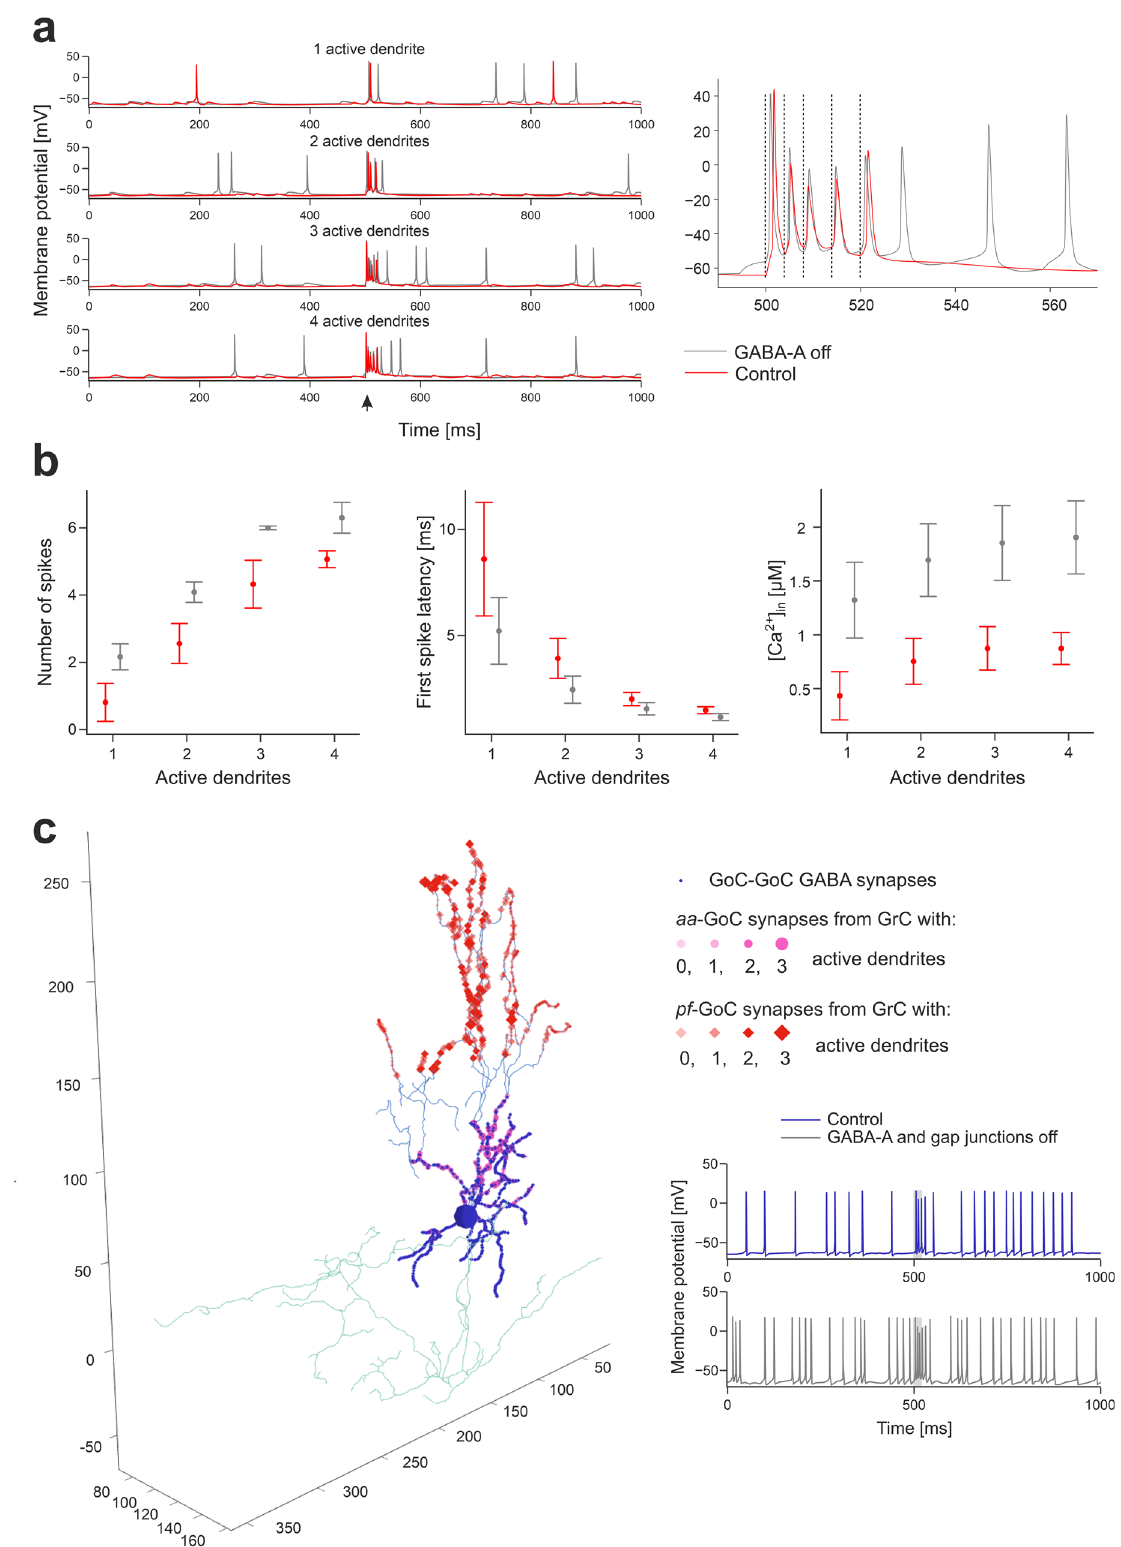
Accurate single-neuron models with realistic morphology proved also critical to carry out simulations allowing us to fi netune the connectome. In particular, the number of inhibitory synapses per GoC - GoC pair was increased in order to make them fi re at ∼ 19 Hz [2-30 Hz range 40,58 ]. Similarly, the number of inhibitory synapses per SC - SC and per BC - BC pairs was tuned